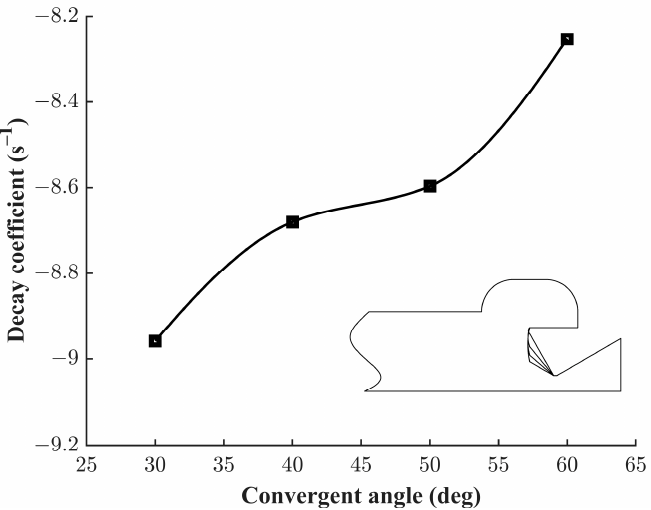
Figure 11. The decay coefficient under different convergent angle.